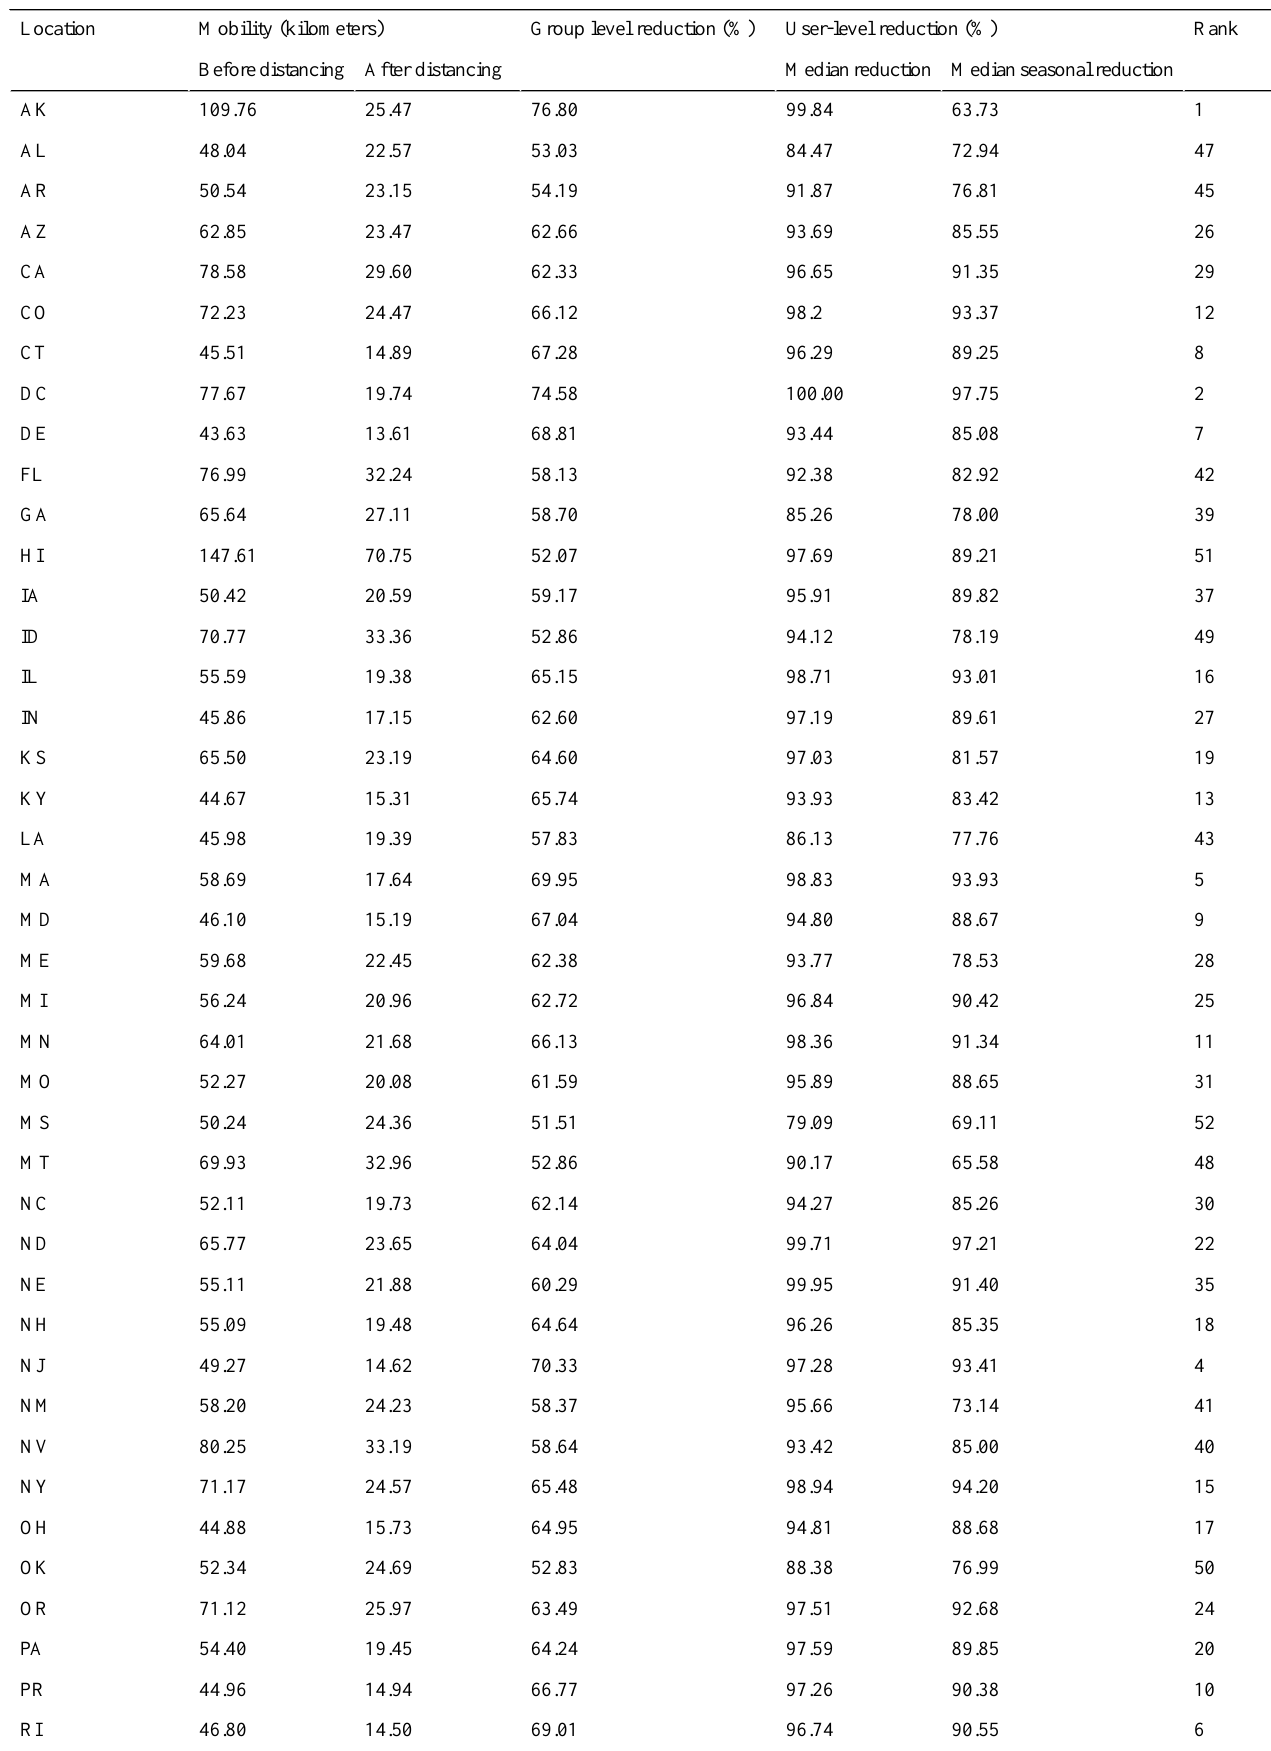
Table 1. Reductions of mobility for all US states and territories and for the United States. Ranks are based on group level